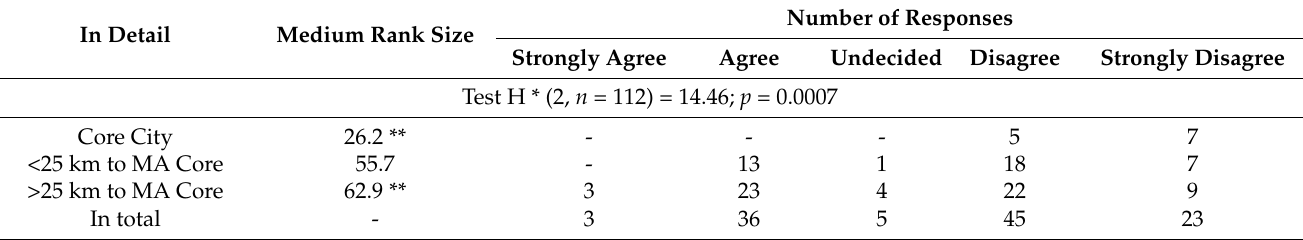
Table 11. Experts’ opinions on increases in farm size until 2027 ( n =